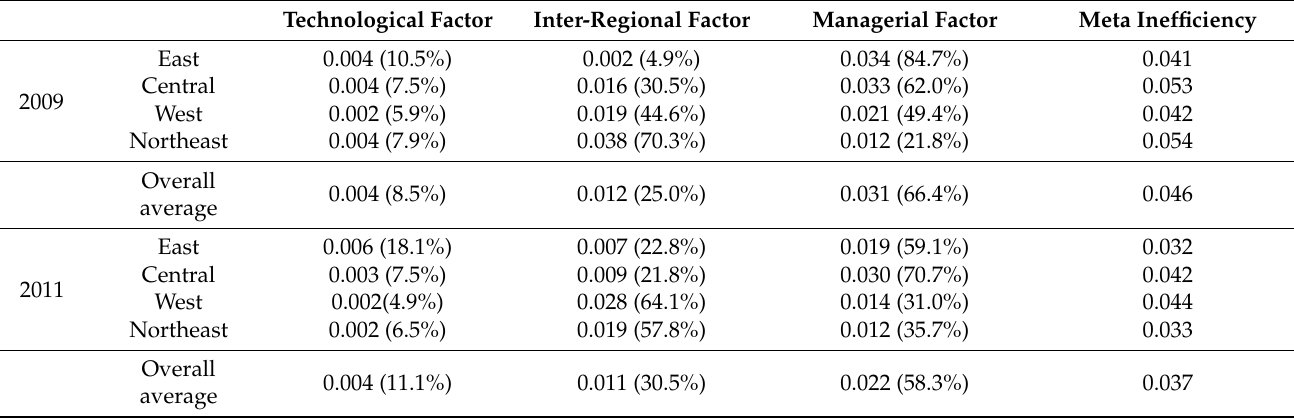
Table 3. Summary of the changes for each inefficiency factor and its components in the LARGE group. The percentage in parentheses represents the proportion of each factor to meta